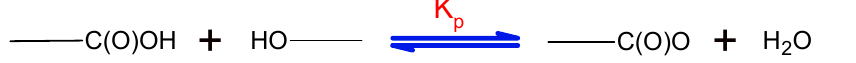
Figure 3. The equilibrium constant of polycondensation reaction of carboxylic acids with alcohols [10].